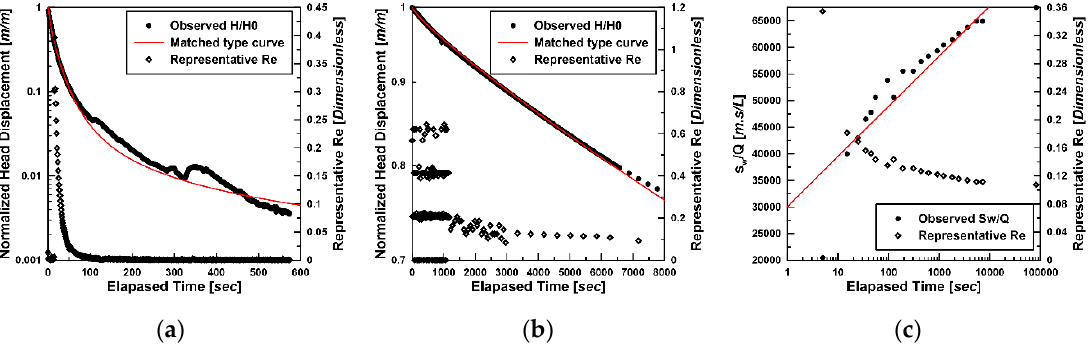
Figure 3. An example of monitored data and calculated representative Re for the ( a ) pulse; ( b ) slug; and ( c ) constant head withdrawal tests at section 3. The red solid lines are the optimized type curves.